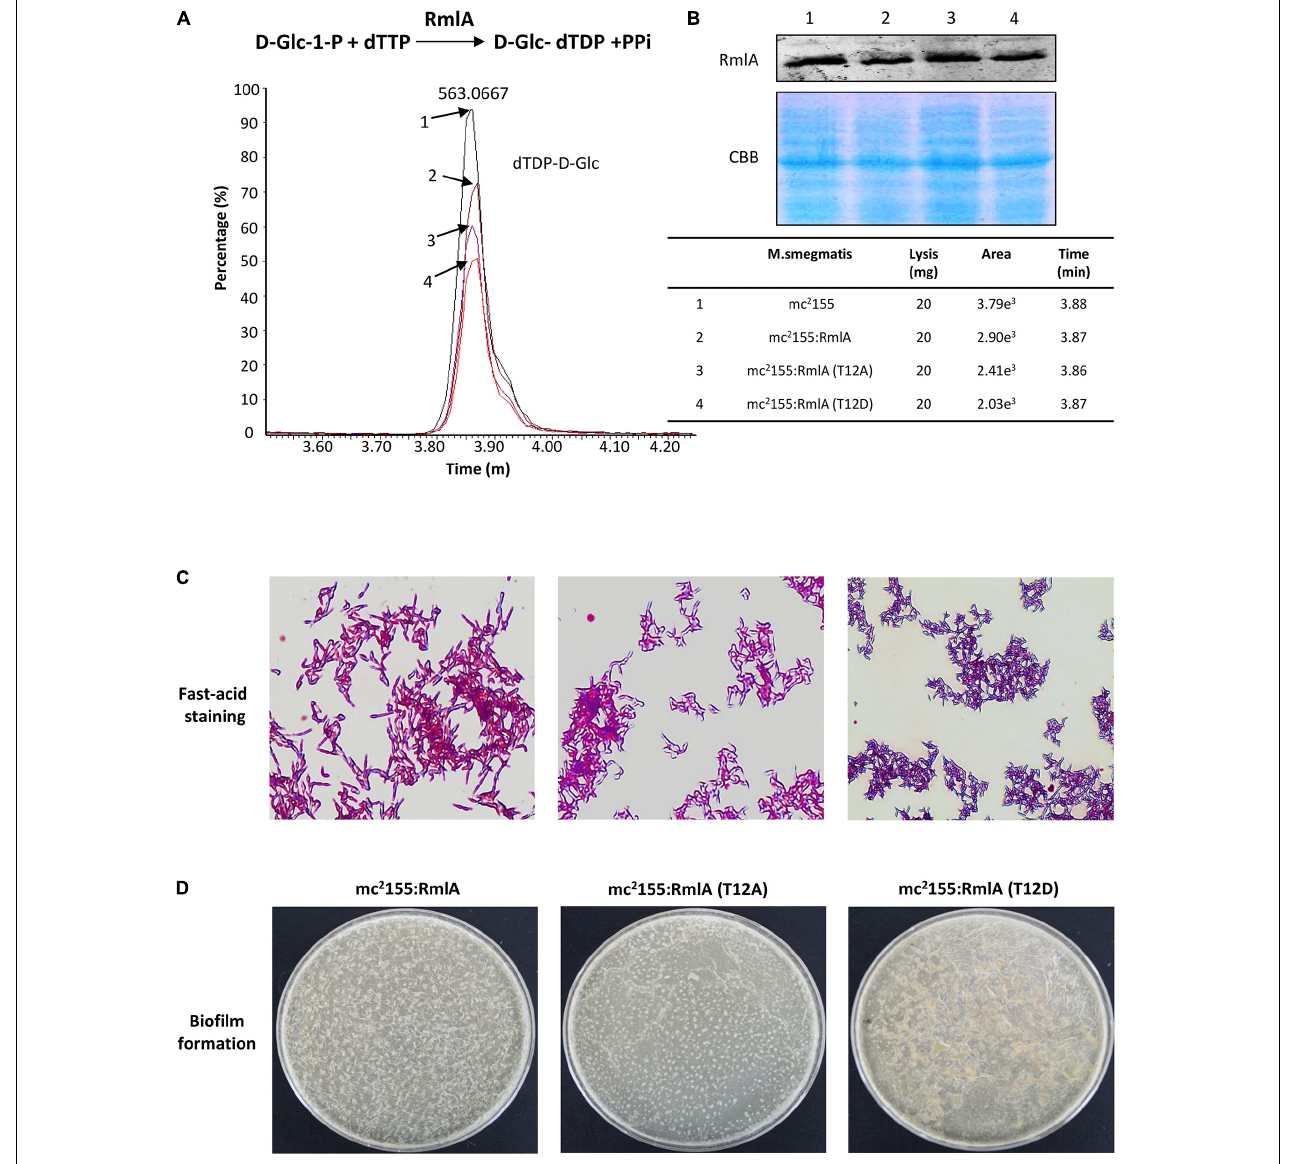
FIGURE 5 | RmlA mutants affect cell morphology. (A) Detection of the activity of RmlA wild type and mutants. An RmlA activity assay was performed using D -Glc-1-P and dTTP as substrates. The major product of this reaction, dTDP- D -Glc, was measured by ultraperformance liquid chromatography and mass spectrometry. (B) Quantification and statistics analysis of the production of dTDP- D -Glc with wild type and mutants of RmlA. (C) Cultures were fixed on glass slides, and acid-fast staining was performed on the fixed smears using the BD Carbolfuchsin kit and detected with optical microscope. Magnification × 40. (D) The biofilm formation of wild type and mutants of RmlA. All the strains were seeded in fresh culture at an initial OD 600 of 0.1 and grown on a liquid surface at 30 ◦ C for 7